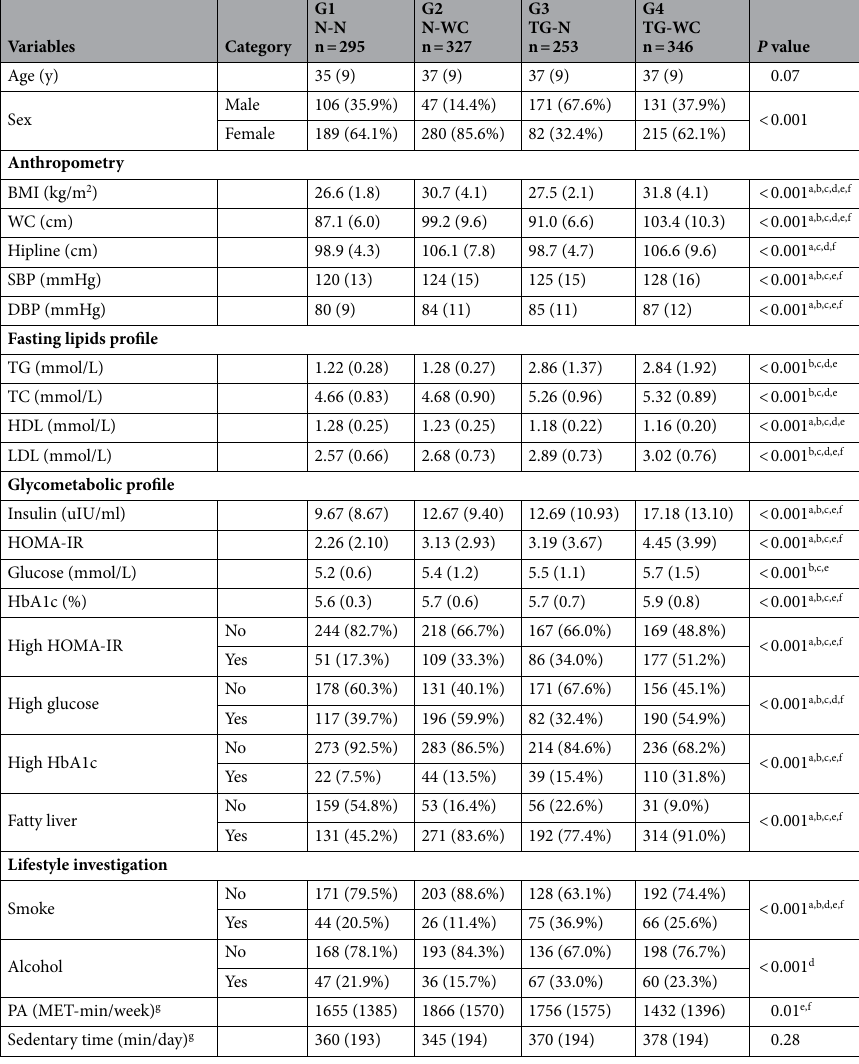
Table 1. General characteristics of participants with different phenotypes. Data expressed as mean (standard deviation [SD]) or n (percent%). G1, N-N, normal TG & normal WC; G2, N-WC, normal TG & high WC; G3, TG-N, high TG & normal WC; G4, TG-WC, high TG & high WC. BMI, body mass index; WC, waist circumference; SBP, systolic blood pressure; DBP, diastolic blood pressure; TG, triglyceride; HOMA-IR, Homeostatic Model Assessment of Insulin Resistance index; HbA1c, glycosylated hemoglobin; TC, total cholesterol; HDL, high density lipoprotein cholesterol; LDL, low density lipoprotein cholesterol; PA, physical activity. a,b,c,d,e,f P < 0.05 for G2 vs G1, G3 vs G1, G4 vs G1, G3 vs G2, G4 vs G2, and G4 vs G3, respectively; g, valid n of participants for G1-4 groups were 215, 229, 203, and 258, respectively. High WC was defined as ≥ 102.0 cm for males and ≥ 88.0 cm for females, high TG as ≥ 1.71 mmol/L, high HOMA-IR as ≥ 3.19, high glucose as ≥ 5.6 mmol/L, and high HbA1c as ≥ 6.5%. Overweight was defined as 24.0 ≤ BMI < 28.0 kg/m 2 , obesity as BMI ≥ 28.0 kg/m 2